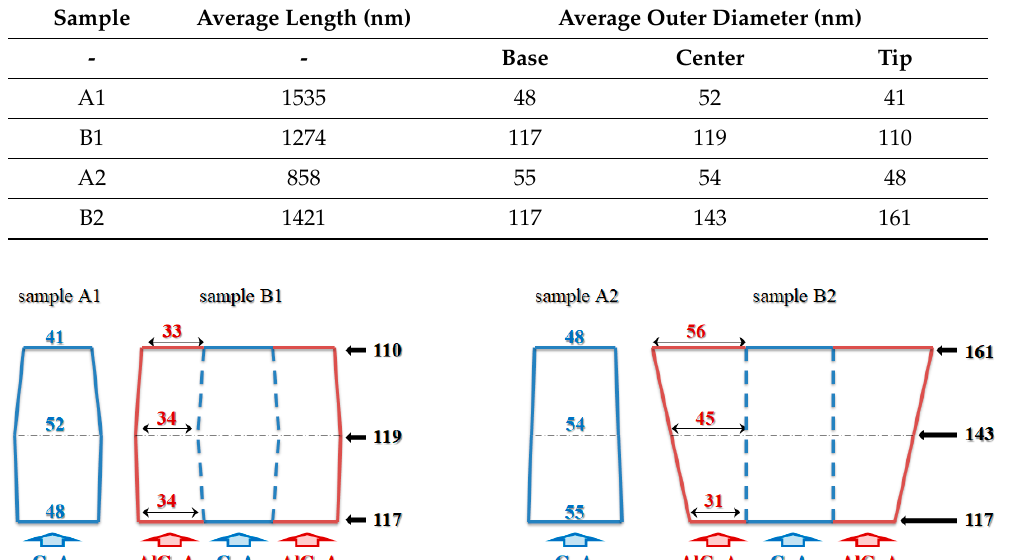
Figure 1. ( a ) 45° tilted scanning electron micrograph of a nontapered GaAs–AlGaAs core–shell nanowire sample qualitatively similar to sample B1 (a nanowire average length of 960 nm, a diameter of 150 nm, and a density of ~10 NW/µm 2 ). Inset: at the top, the different contrasts along the radial direction indicate the different materials of the core and the shell; ( b ) Sketch of a core–shell nanowire (NW). The core and shell materials and the typical dimensions are indicated: an inner diameter of d ≈ 80 nm, an outer diameter of D ≈ 150 nm, and a shell thickness of t = 35 nm; ( c ) Schematics of the phenomena that occurred as light shined on the lateral surface of a core–shell NW: the latter behaved as a nanomirror, where the radial heterostructure implemented a double interface (air/shell and shell/core), likely yielding to marked interference effects. Table 1. Morphological parameters of the investigated samples. Average Outer Diameter (nm)